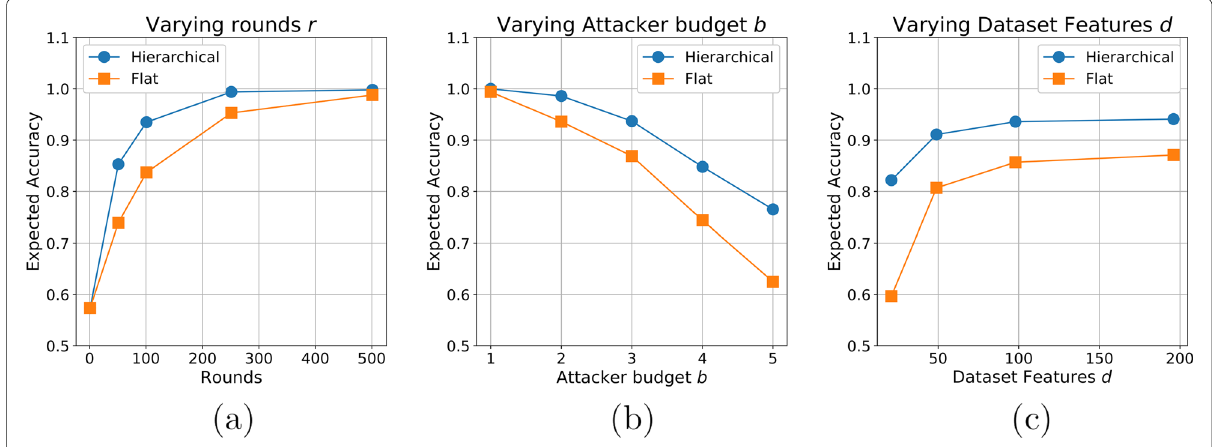
Fig. 4 Flat vs. hierarchical ensembling